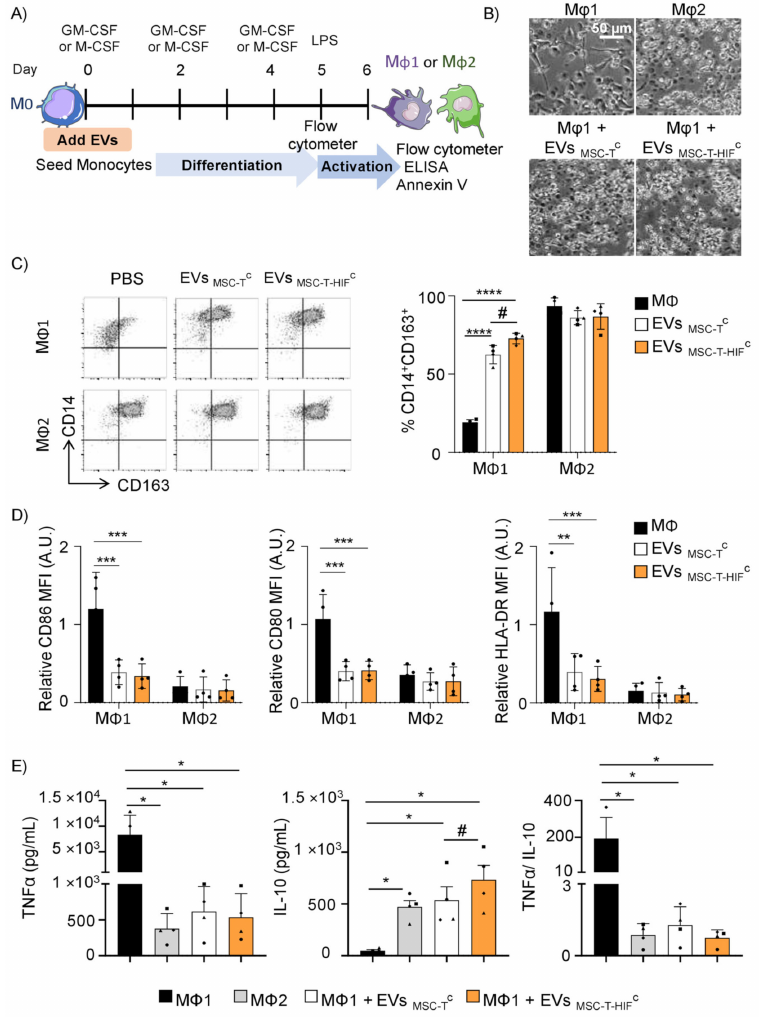
Figure 2. EV MSC-T-HIFC are superior to EV MSC-TC in repolarizing M ϕ 1 to an M ϕ 2-like phenotype. ( A ) Scheme of the in vitro experimental design; ( B ) brightfield microscopy images of M ϕ after five days of differentiation. Scale bar: 50 µ m. ( C ) After 5 days of differentiation, the percentage of CD14 + and CD163 + cells were assessed by flow cytometry. Representative dot plots are shown. Black bars represent M ϕ 1 or M ϕ 2 without EVs, respectively. Graph represents mean ± SD of four independent experiments. Two-way ANOVA was used for statistical analysis. ( D ) Sixteen hours after lipopolysaccharide (LPS) activation, CD86, CD80 and HLA-DR expression was assessed by flow cytometry. Relative mean fluorescence intensity (MFI) was calculated by dividing all individual data by the mean expression in M ϕ 1. Black bars represent M ϕ 1 or M ϕ 2 without EVs, respectively. Graphs represent mean ± SD of four independent experiments. Two-way ANOVA was used for statistical analysis. ( E ) TNF- α and interleukin IL-10 production by M ϕ was determined by ELISA 16 h after LPS stimulation. Black bars represent M ϕ 1 and gray bars M ϕ 2 without EVs, respectively. Graphs represent mean ± SD of four independent experiments. One-way ANOVA with Geisser–Greenhouse correction was used for statistical analysis. Each symbol ( • , (cid:4) , (cid:78) , (cid:7) ) represents a different paired experiment. * or # p < 0.05, ** p < 0.01, *** p < 0.001, **** p <